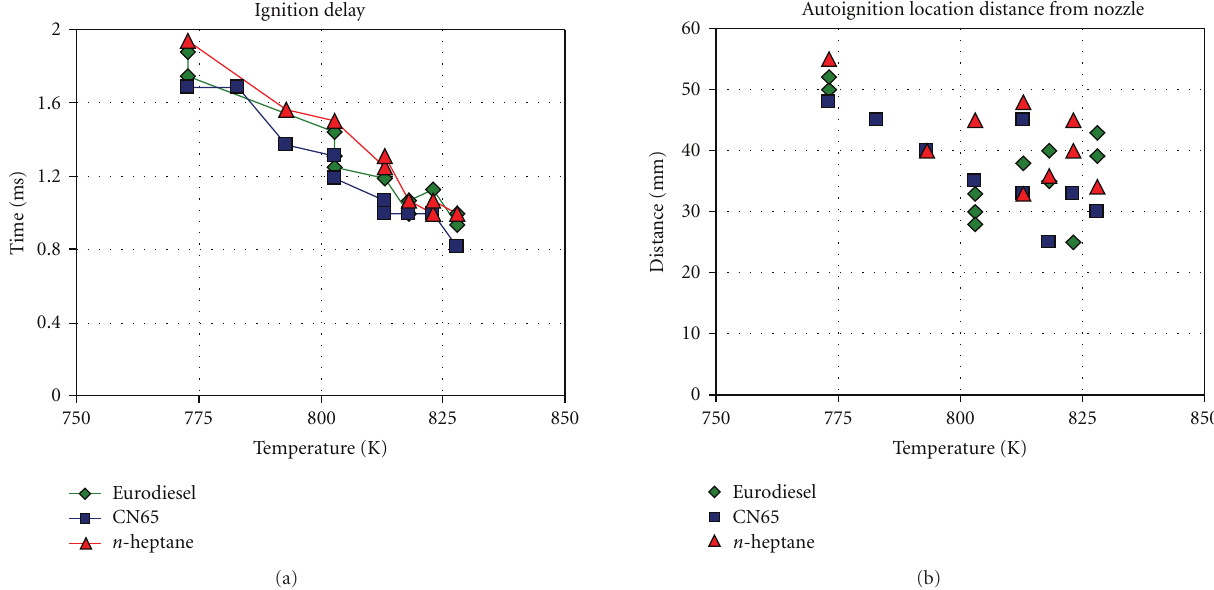
Figure 22: Ignition delay time and autoignition location distance from nozzle tip for di ff erent type of fuels (3.5MPa ambient pressure, 50MPa injection pressure, 1.5 ms injection